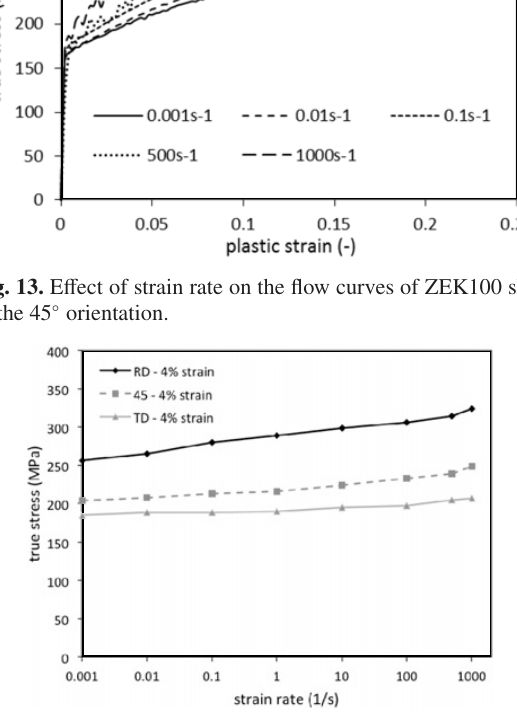
Fig. 14. True stress vs. strain rate for ZEK100 sheet in the RD, TD and 45 ◦ orientation at 4%